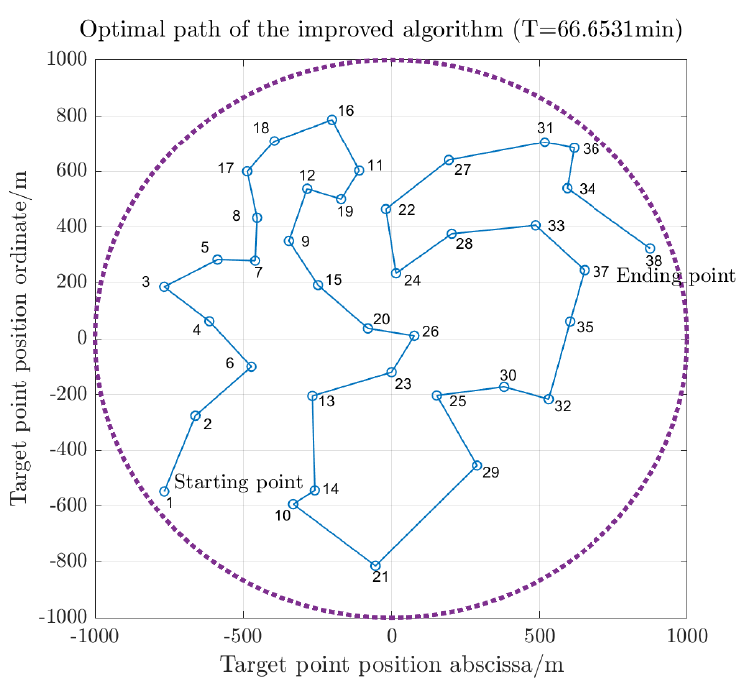
Figure 8. Optimal path generated by the improved algorithm.